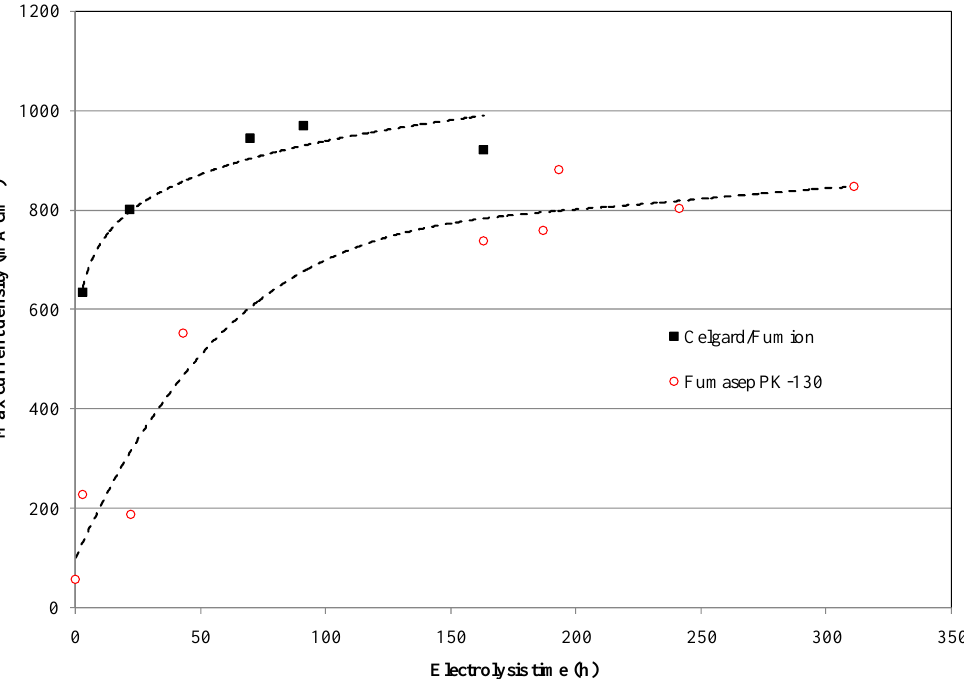
Figure 10. Maximum current density profile at 3.1 V vs. time on Fumasep-PK-130 and Cel- gard/Fumion at 25 °C.